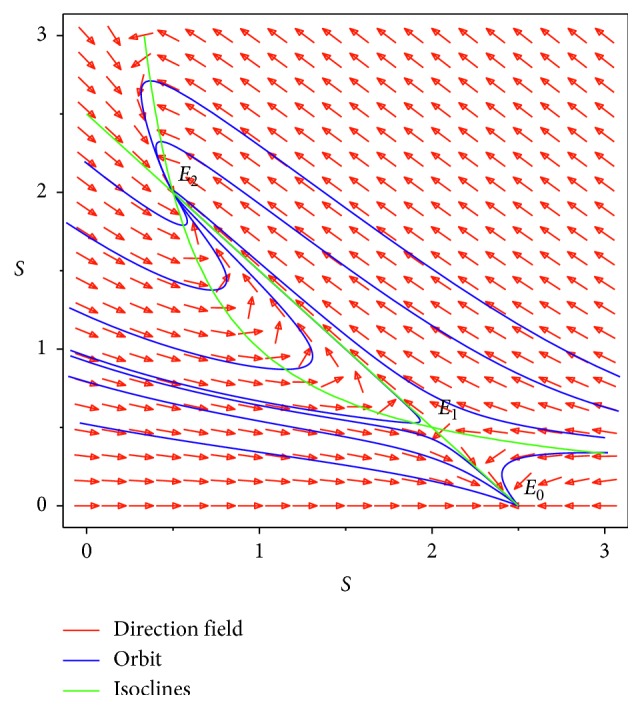
Phase diagram of system (3) with θ=2.5, β=1, and  γ=1.